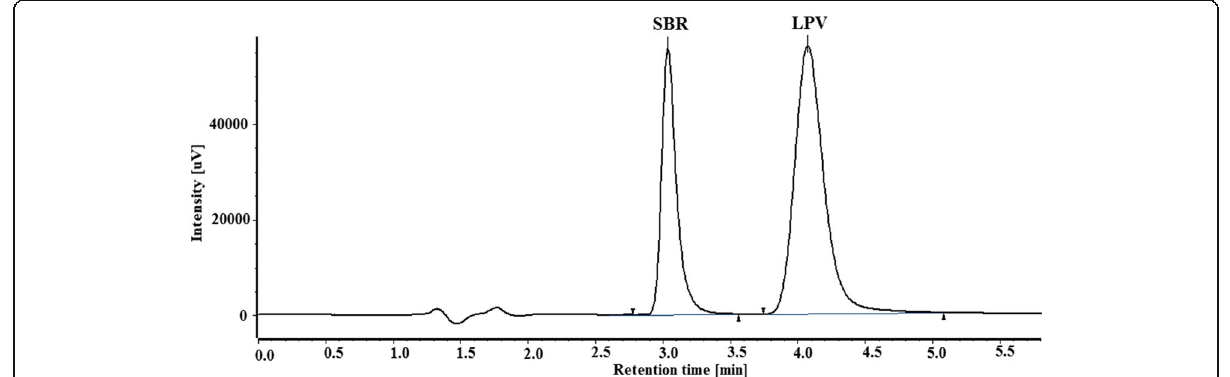
Fig. 4 HPLC chromatogram of 40 μ g/mL of SBR and 30 μ g/mL of LPV